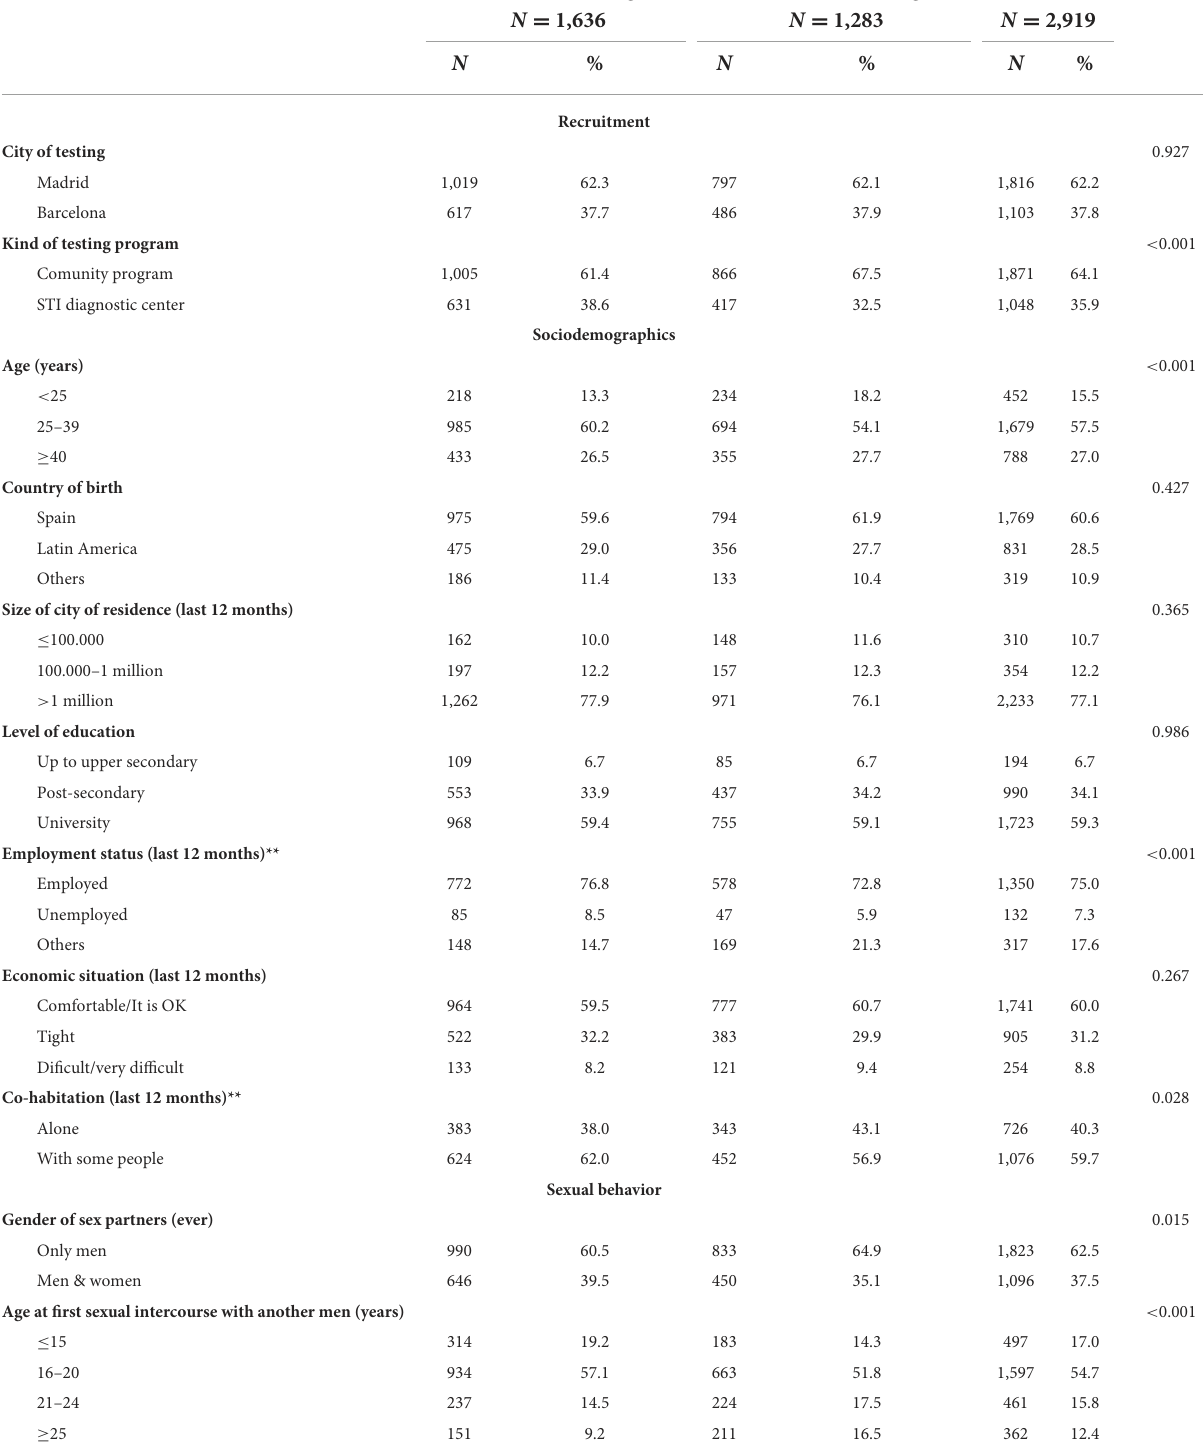
TABLE 1 Sample characteristics of MSM * from Madrid and Barcelona by lifetime sexualized drug use ( N =